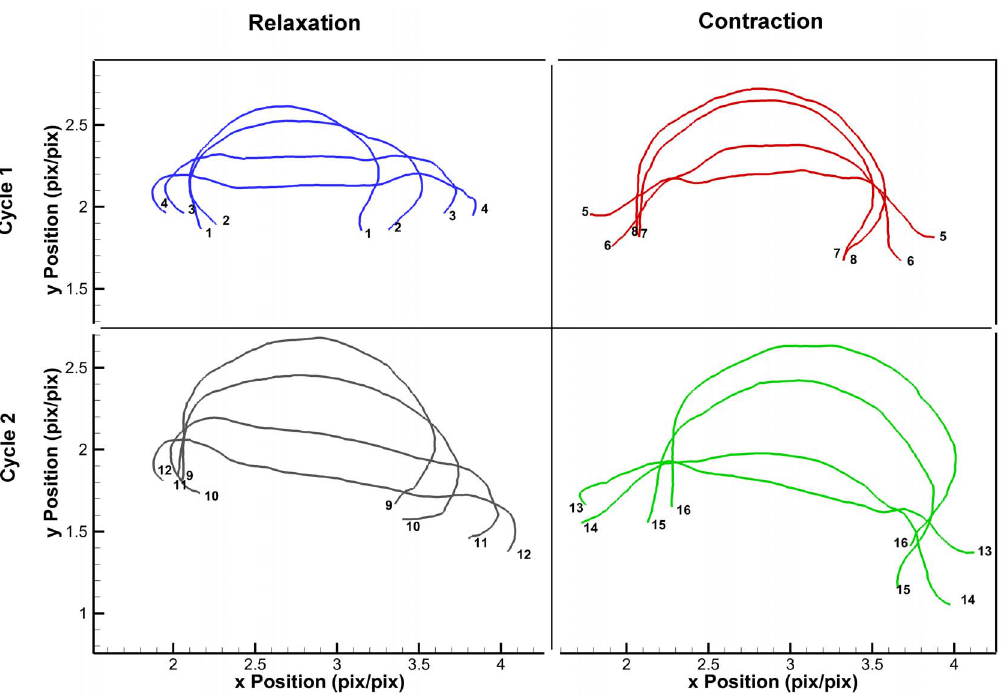
Fig. 3. Exumbrella profiles during swimming. Cyanea capillata exumbrella profiles over two full swimming cycles before processing. Profile tips are numerically labeled in order of occurrence. Note the change in apparent animal size over just two swimming cycles. The profiles displayed were manually selected in order to fully display the bell kinematics at different instances. Each contraction and relaxation phases for both cycles are represented by a different color. The position has been normalized by the half exumbrella arclength in the relaxed position of the first cycle.